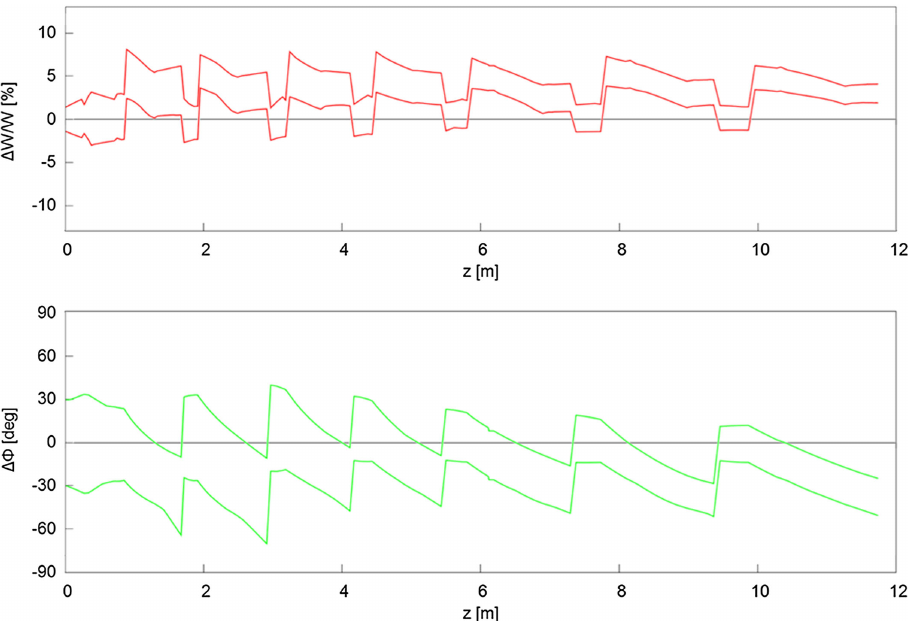
FIG. 13. Longitudinal 100% beam envelopes (all particles are included; top, relative energy spread; bottom, phase